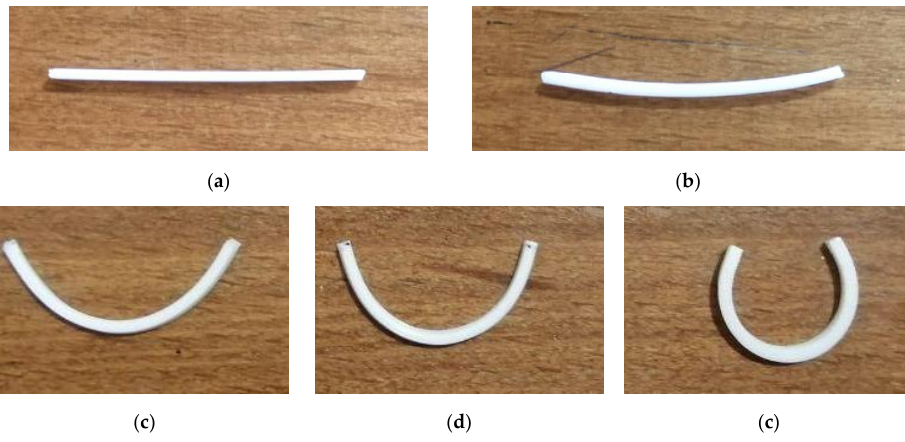
Figure 4. The configuration of the samples 4D-printed at different speeds of ( a ) 5, ( b ) 10, ( c ) 20, ( d ) 40, and ( e ) 70 mm/s after the heating – cooling process.